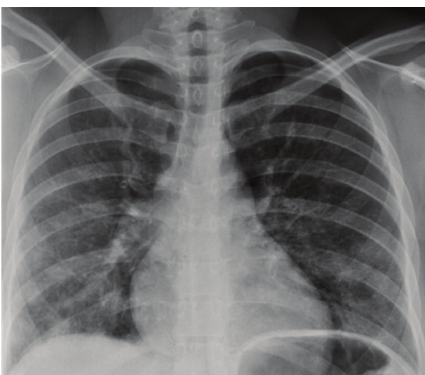
Figure 1: A 30-year-old female after illicit silicone injection. Find- ings: PA chest radiograph demonstrates diffuse haziness throughout the middle and lower lungs especially in the right lower lung.